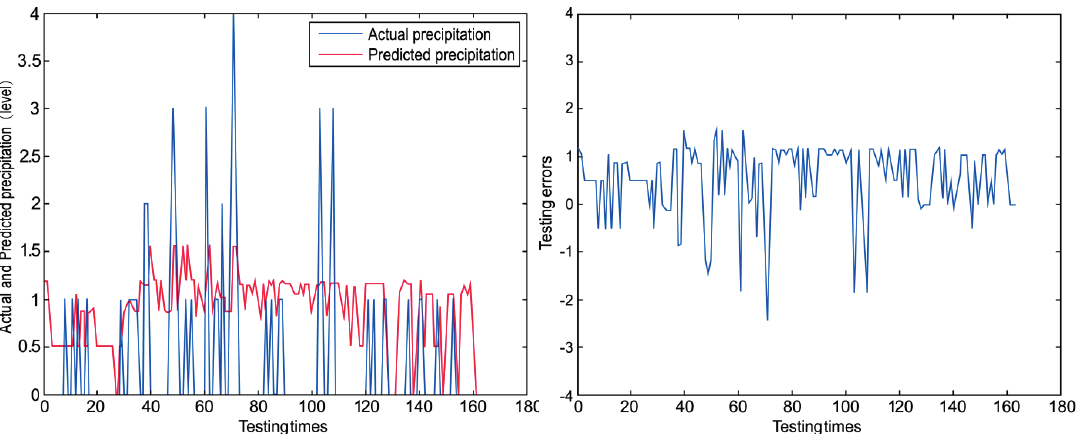
Figure 8. Testing results of NFIS-WPM (Ave).